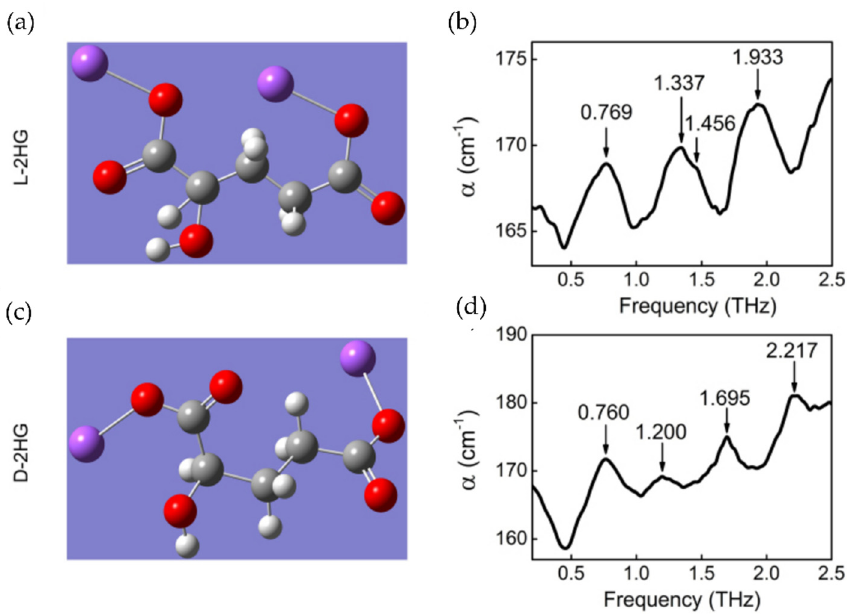
Mutant isocitrate dehydrogenase 1 (IDH1) is common in gliomas, which produces Myo-Inositol has also been found to be increased in gliomatosis and other cerebral diseases associated with marked astrogliosis [165]. Apart from the concentration of Myo-Inositol, the ratio between Myo-Inositol and creatine can also be used to predict the grade of cerebral gliomas. Myo-Inositol/creatine was higher (2.14 ± 1.4) in patients with 2HGDS: 0.769, 1.337, 1.456, and 1.933 THz; D-2HGDS: 0.760, 1.200, 1.695, and 2.217 THz) low-grade astrocytoma and lower in patients with anaplastic astrocytoma (0.39 ± 0.11) (Figure 15). However, there is still a difference between 2-HG and 2HGDS, where the acid and glioblastoma (0.025 ± 0.06) [166]. These two substances have also been tested by THz group may have different vibration modes in a disodium salt state.